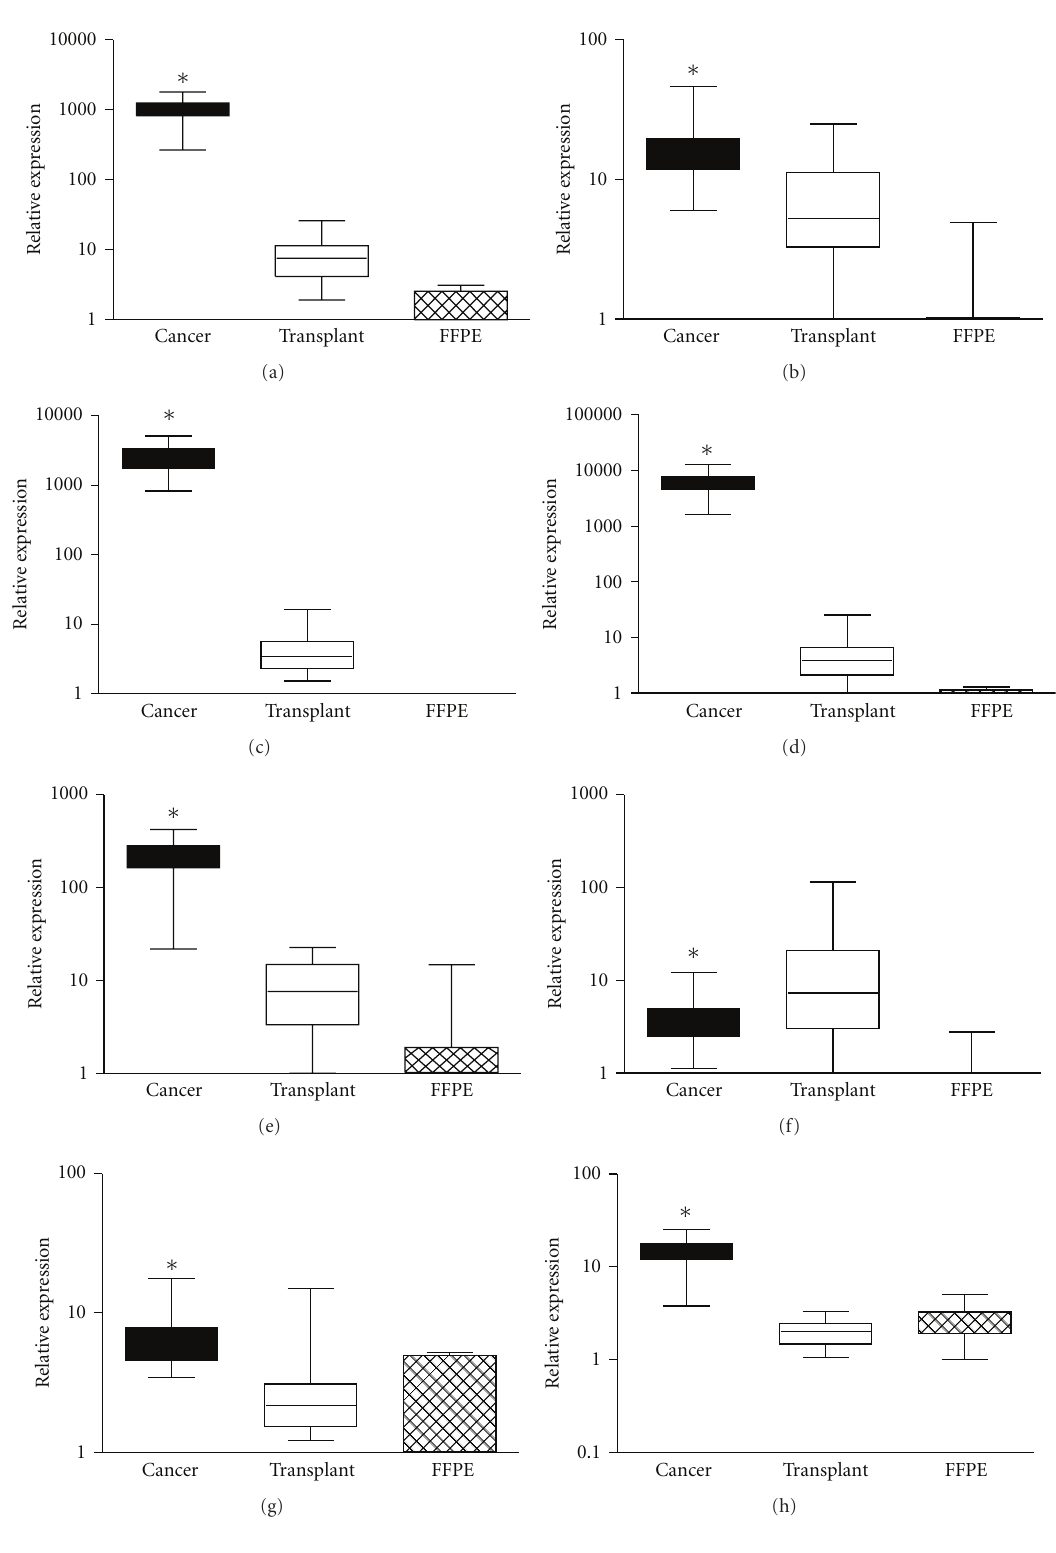
Figure 1: Quantitative real-time PCR analysis of VEGFA (a), PGF (b), FLT1 (c), KDR (d), MMP-2 (e), MMP-9 (f), TIMP-1 (g), and TIMP-2 (h). Gene expression levels were increased for VEGFA, PGF, FLT1, KDR, MMP-2, TIMP-1, and TIMP-2 in lung cancer ( n = 29) compared to formalin-fixed para ffi n-embedded (FFPE) tissue ( n = 7) and stable lung transplant biopsies ( n = 26). The levels of MMP-9 were significantly decreased. Results are expressed as mean ± SD. Asterisks indicate P < 0 .